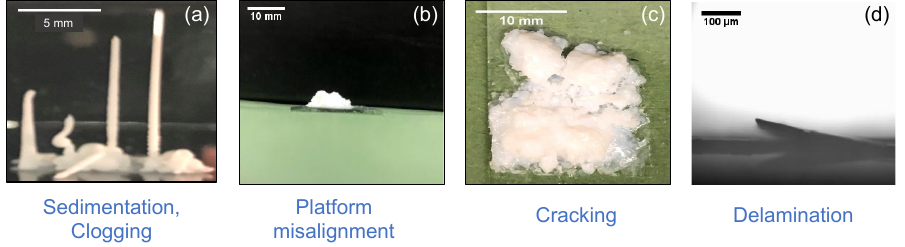
Figure 6. Typical challenges in spray printing of nanosuspensions. Failure of substrate construction is likely, even if only one of these effects